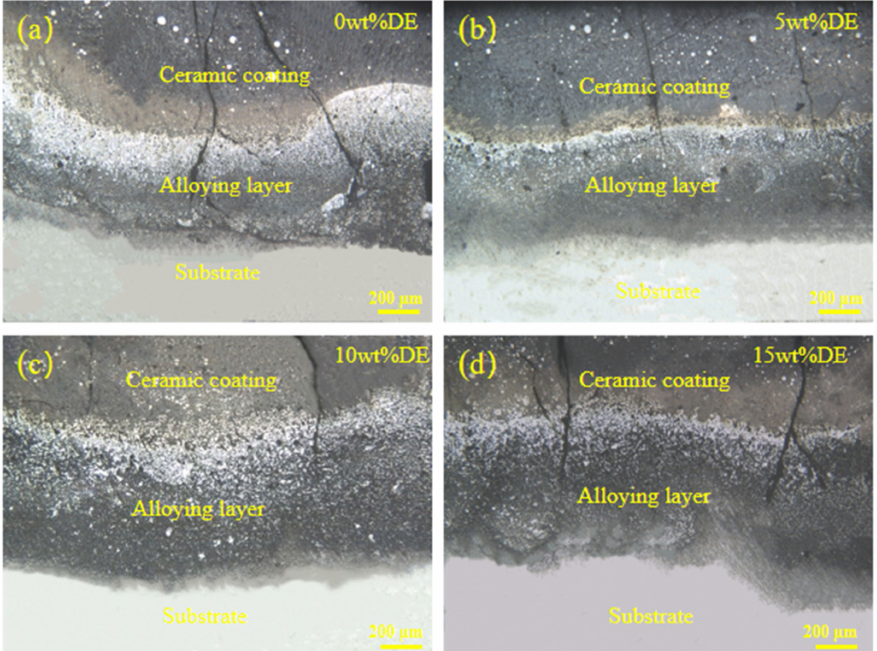
Figure 3. Cross-sectional microstructure of bioceramic coating with different contents of DE, ( a ) 0wt%;